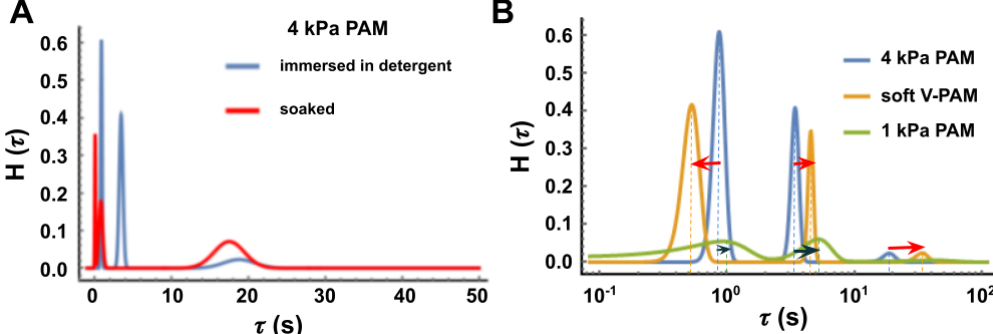
Figure A4. To report on the experimental variability, we plotted a distribution of characteristic relaxation times (repre-